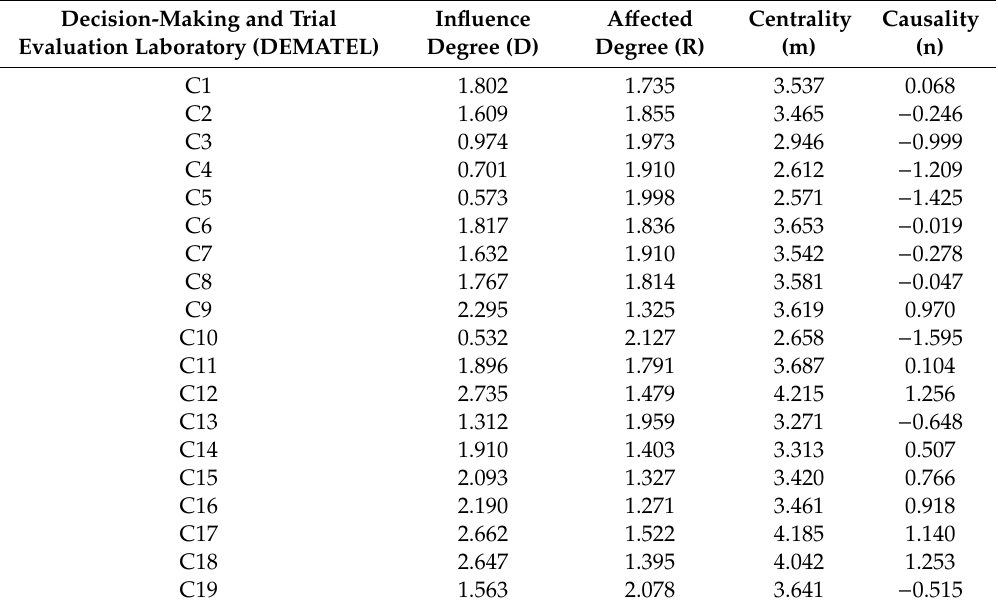
Figure 2. Decision-making and trial evaluation laboratory (DEMATEL) causal diagram. Table 6. Comprehensive impact matrix